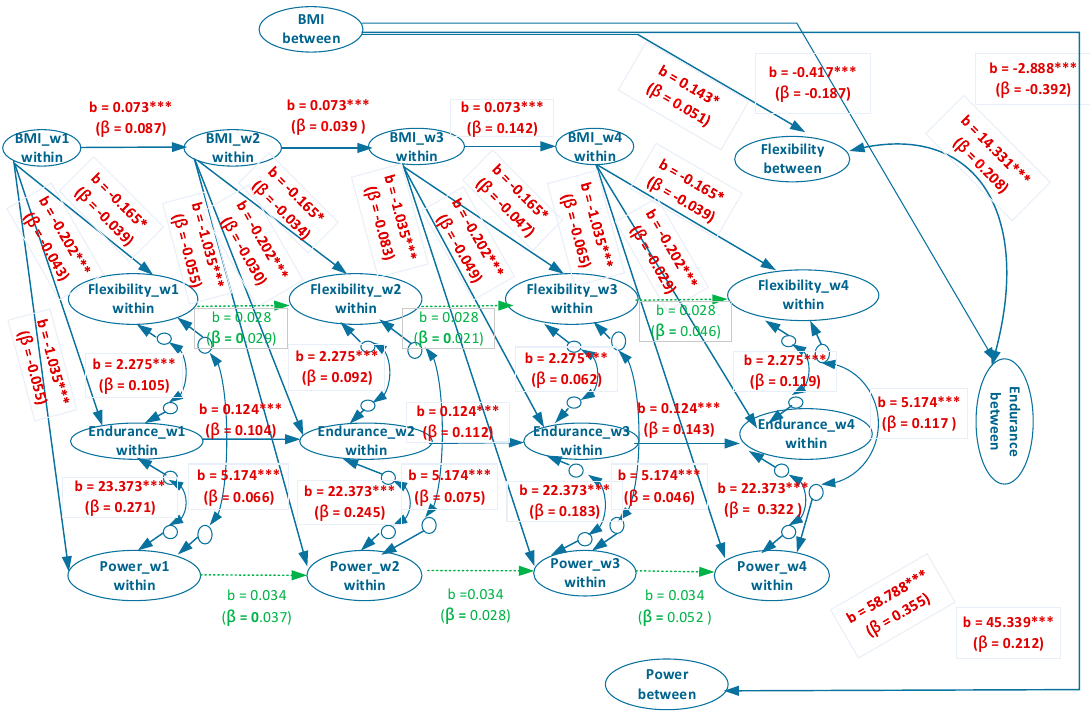
Figure 3. Simplified representation of the estimated random-intercept panel model for male participants.